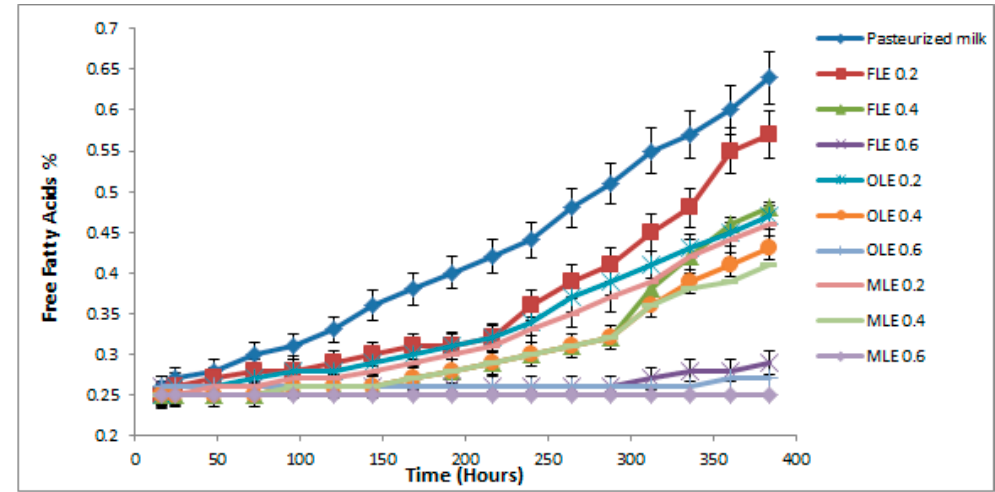
Figure 6. Observed average shelf stability of pasteurized buffalo milk enriched with FLE, OLE, and MLE, using free fatty acids at 5 °C for 16 days. Vertical bars show the standard error of the samples mean.